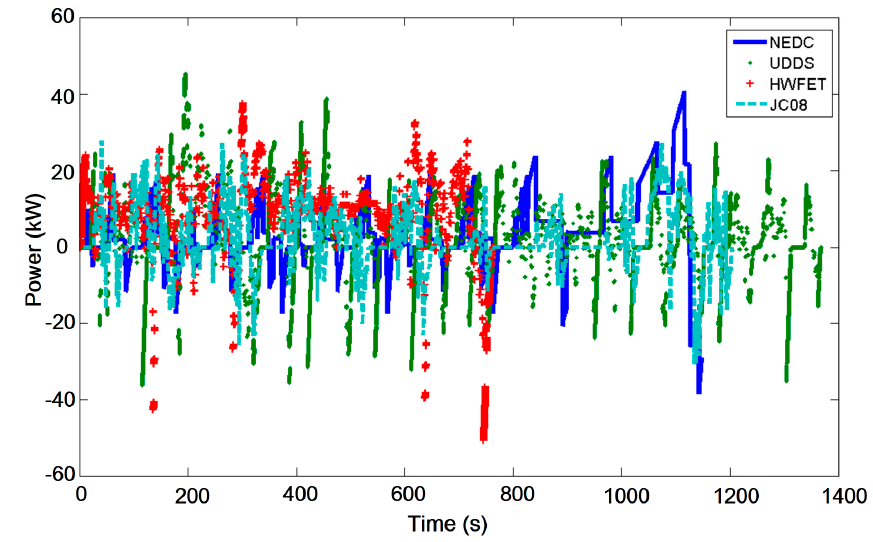
( d ) Figure10. (a) Histogram of the requested traction motor output power distribution in NEDC cycle; ( b ) Histogram of the requested traction motor output power distribution in UDDS cycle; ( c )